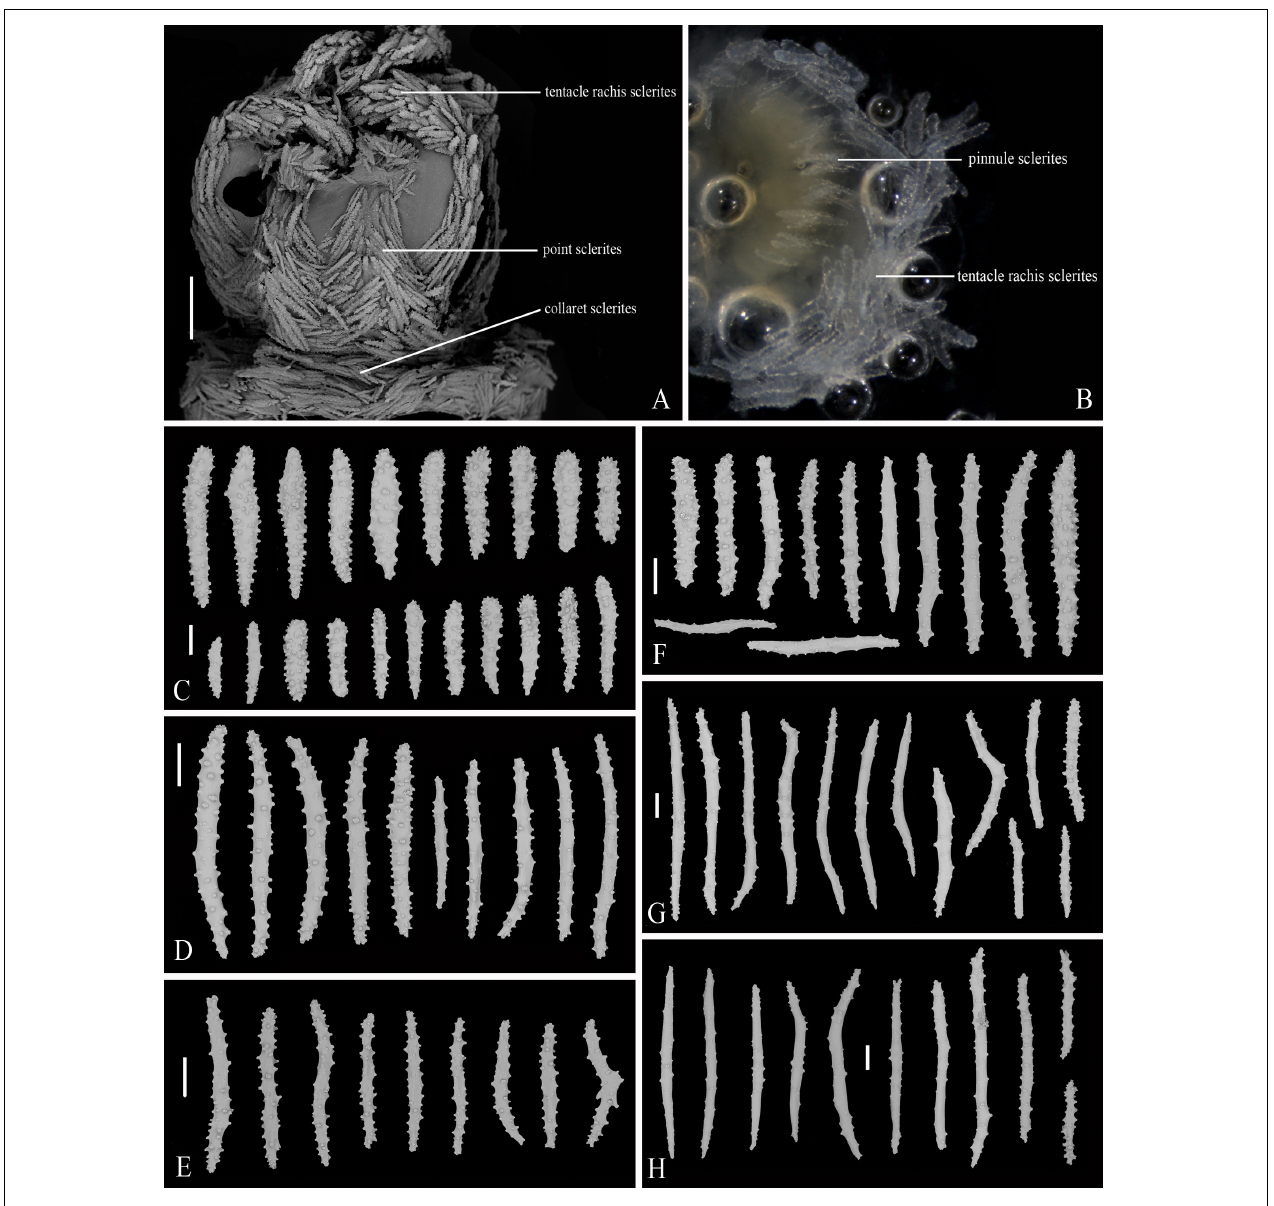
FIGURE 6 | Polyp, tentacle and sclerites of Victorgorgia iocasica sp. nov. (A) SEM of lateral view of polyp head. (B) Tentacle in digestion, showing the location and arrangement of sclerites in rachis and pinnules. (C) Sclerites from tentacles. (D) Sclerites from points and collarets. (E) Sclerites from calyces. (F) Sclerites from cortex. (G) Sclerites from medulla of the branch tip. (H) Sclerites from medulla of the branch close to main stem. Scale bars = 0.5 mm (A) , and 100 µ m (C–H)